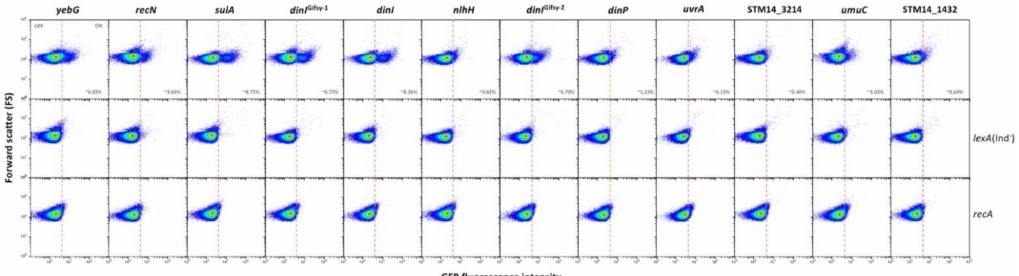
Figure 1. LexA-dependent bistability of group I loci in the absence of known DNA damage. The dashed line shows the boundary between OFF and ON states, established as the expression level of a non-fluorescent sample (Supplementary Figure S2).